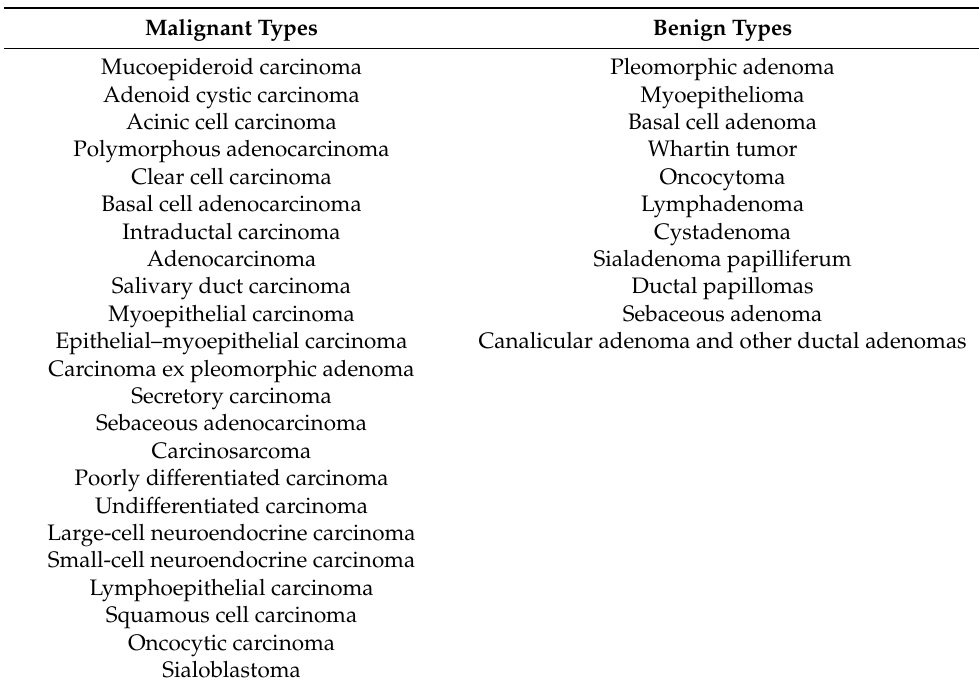
Table 1. WHO classification of malignant and benign salivary gland